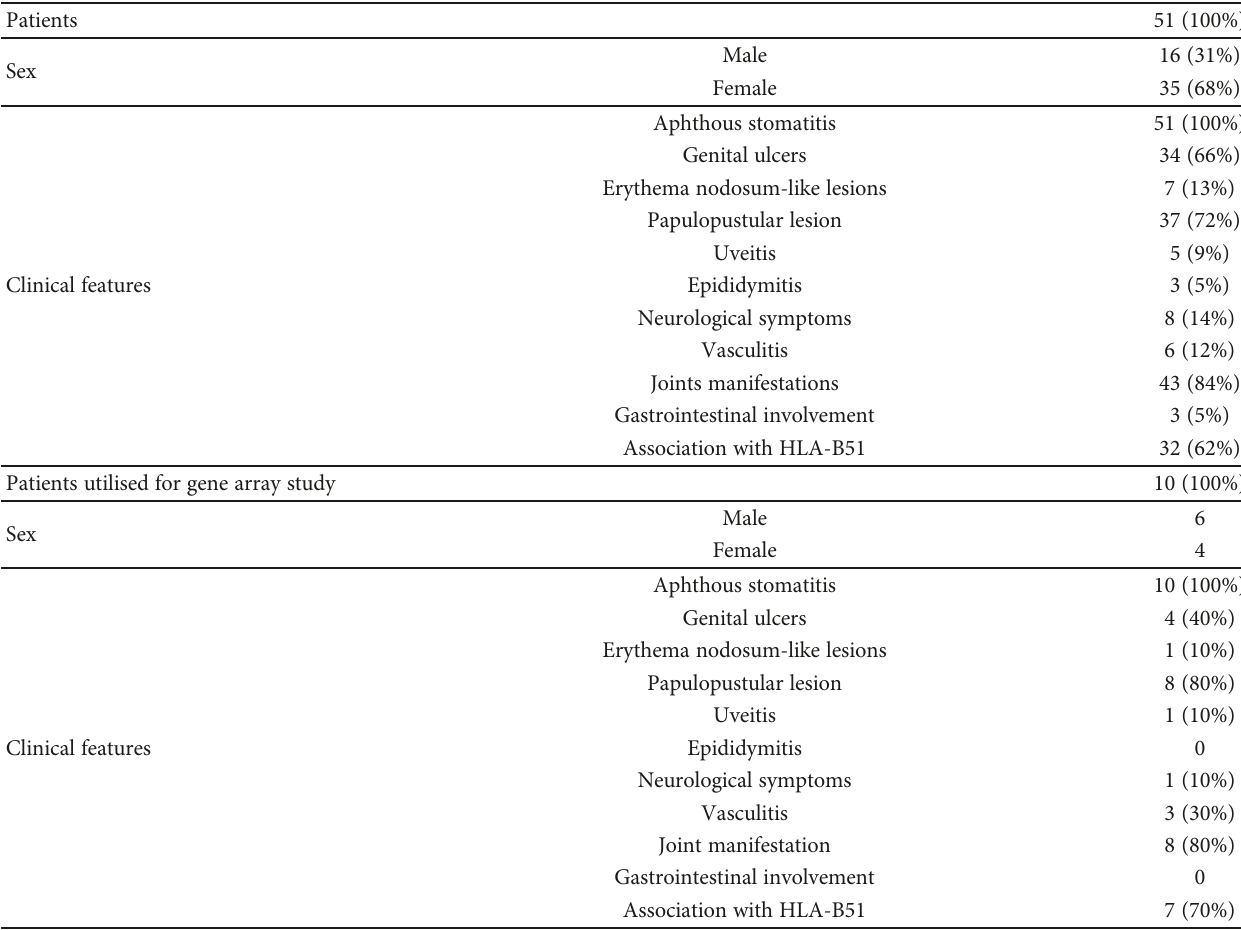
Table 1: Clinical features of the patients with BD included in the study.